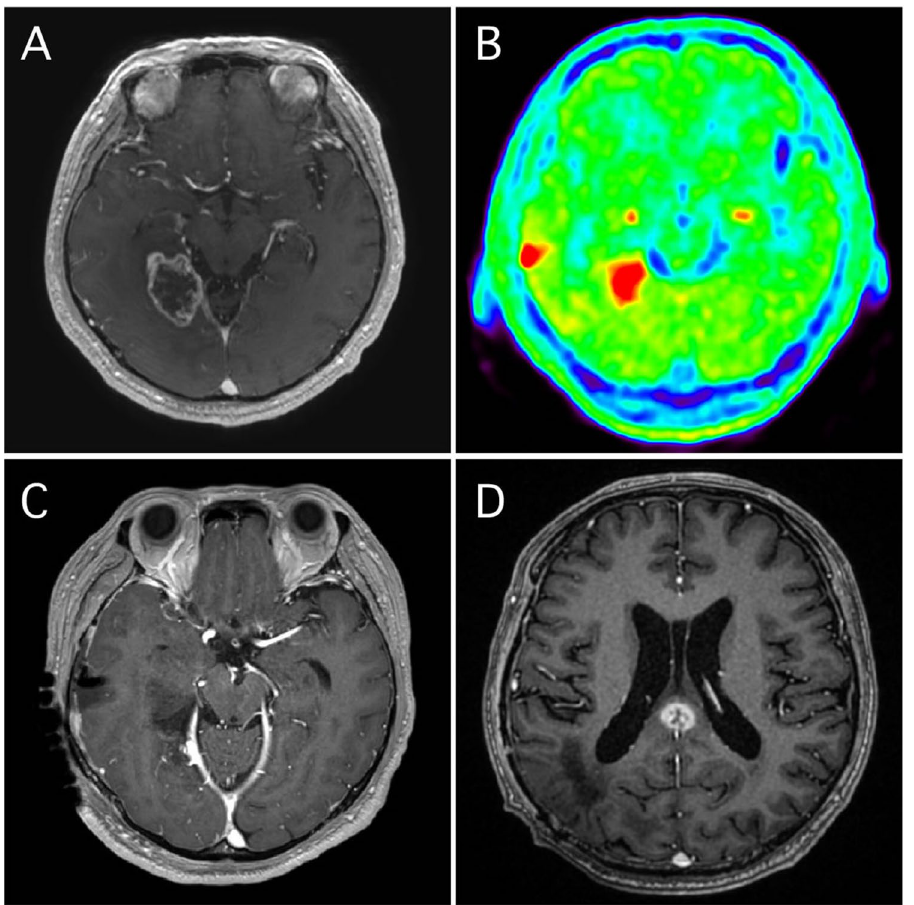
Figure 5. Illustrative case of distant recurrence after supratotal resection with Met-PET. A contrast-enhanced tumor was observed in the right parahippocampal and lingual gyri ( A ). Additionally, Met uptake was also evident in the right middle temporal gyrus ( B ) on PET. Supratotal resection of both the contrast-enhanced area and the area of Met uptake was completed under awake cortical and subcortical mapping for preservation of right optic radiation ( C ). However, distant tumor recurrence was demonstrated in the splenium of the corpus callosum 23.9 months after resection ( D